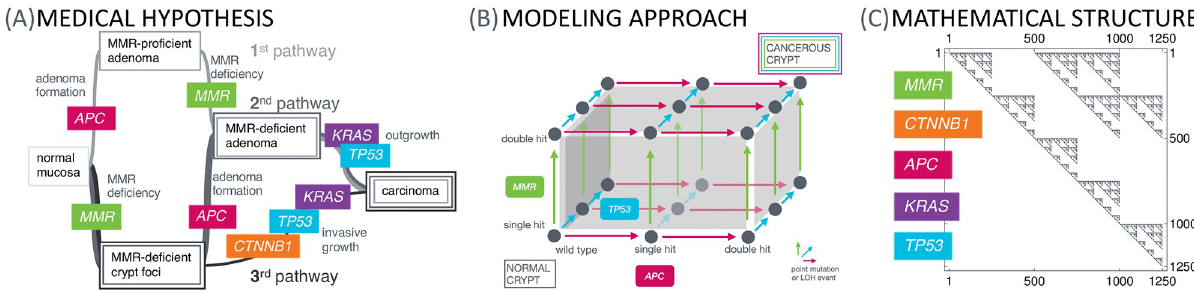
Fig 1. From the medical hypothesis over the modeling approach to the mathematical structure. The medical hypothesis of multiple pathways of carcinogenesis is widely known for various types of cancer. (A) We present a model for this phenomenon at the example of Lynch syndrome, the most common inherited CRC syndrome, with specific key driver events in the MMR genes, CTNNB1 , APC , KRAS and TP53 . (B) This current medical understanding of carcinogenesis is translated into a mathematical model using a specific dynamical system, which can be represented by a graph structure, where each vertex in the graph represents a genotypic state and the edges correspond to the transition probabilities between those states. Starting with all colonic crypts in the state of all genes being wild-type and a single MMR germline variant due to Lynch syndrome, we are interested in the distribution of the crypts among the graph at different ages of the patient in order to obtain estimates for the number of crypts in specific states, e.g., adenomatous or cancerous states. (C) The underlying matrix of the dynamical system makes use of the Kronecker sum and product. It is a sparse upper triangular matrix accounting for the assumption that mutations cannot be reverted. This allows fast numerical solving by using the matrix exponential. Each nonzero entry of the matrix represents a connection between genotypic states in the